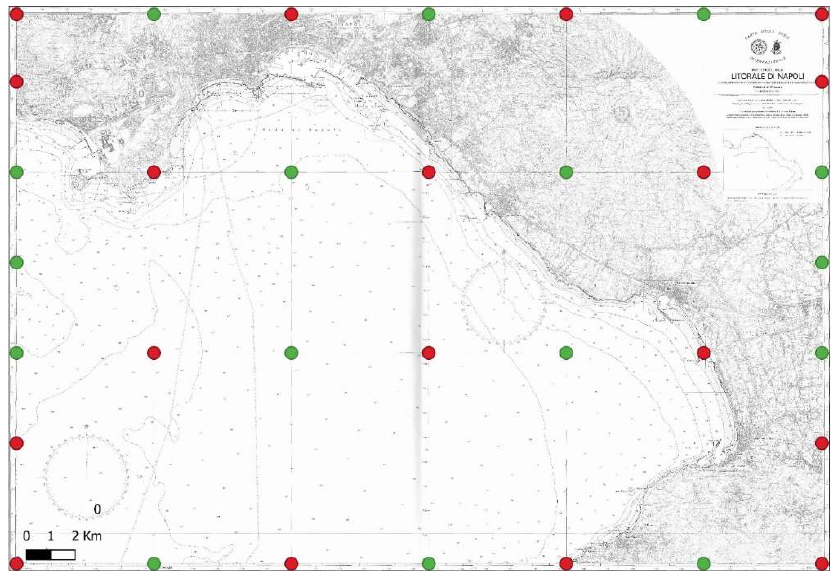
Figure 11. The GCPs (red dots) and CPs (green dots) chosen for georeferencing the nautical chart.